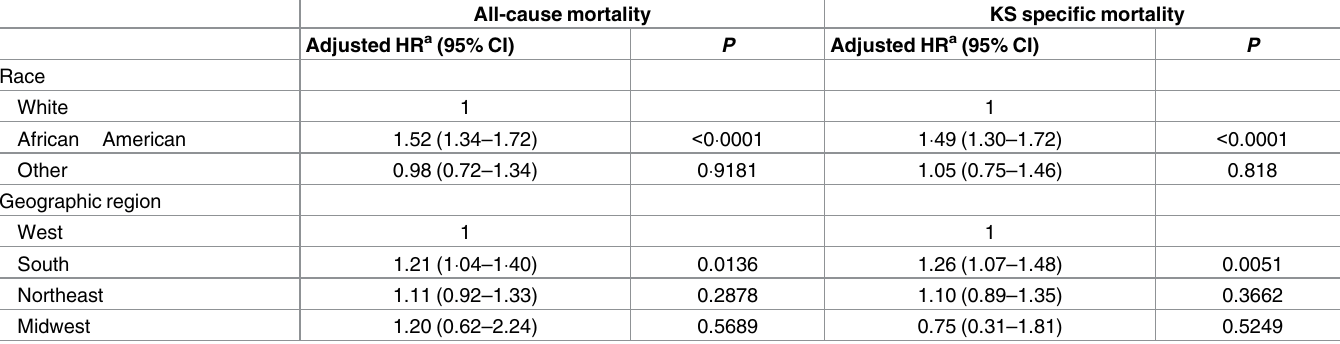
Table 2. Crude and adjusted hazard ratios (HR) and 95% confidence intervals (CI) for all-cause and Kaposi sarcoma(KS)-specific mortality among men with KS between 2000 and 2013 (N = 3,749).